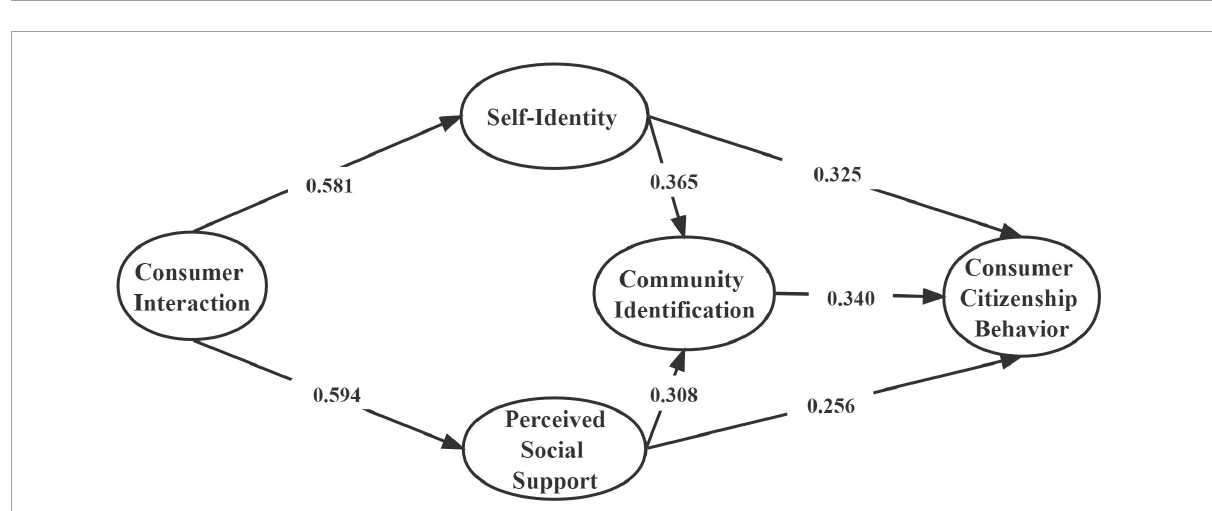
FIGURE3 Standardization path map of unlimited model of symbolic motivation. χ 2 = 3755.774, df = 1696, χ 2 / df = 2.214, TCL = 0.941, CFI = 0.941, NFI = 0.897, RMSEA =